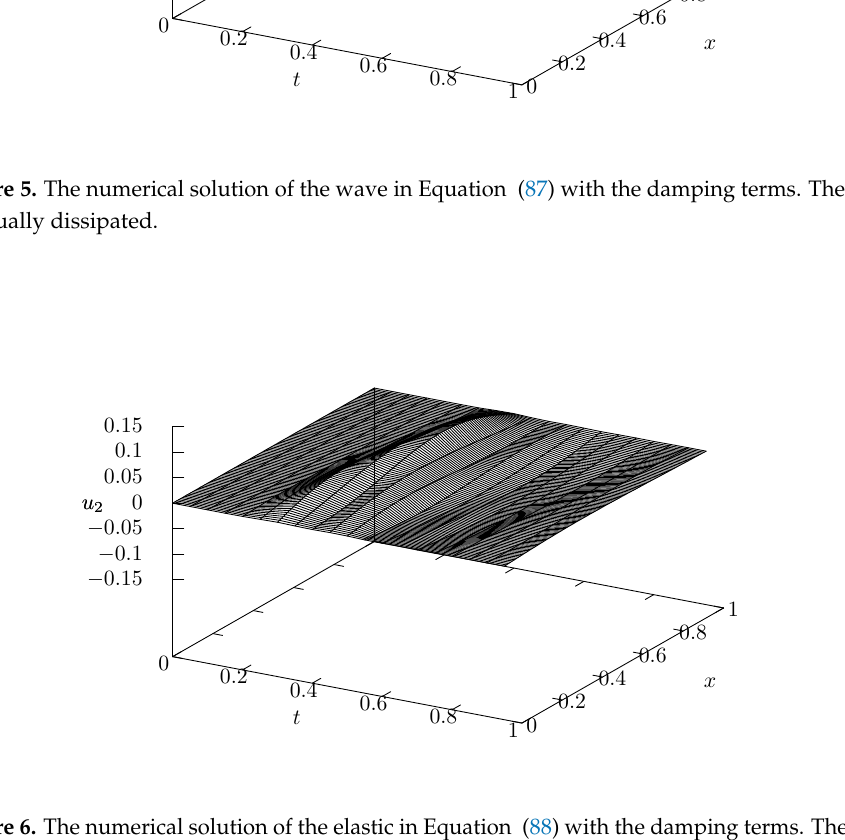
Figure 6. The numerical solution of the elastic in Equation (88) with the damping terms. The excitation due to the energy exchange is smaller than that in the case without the damping